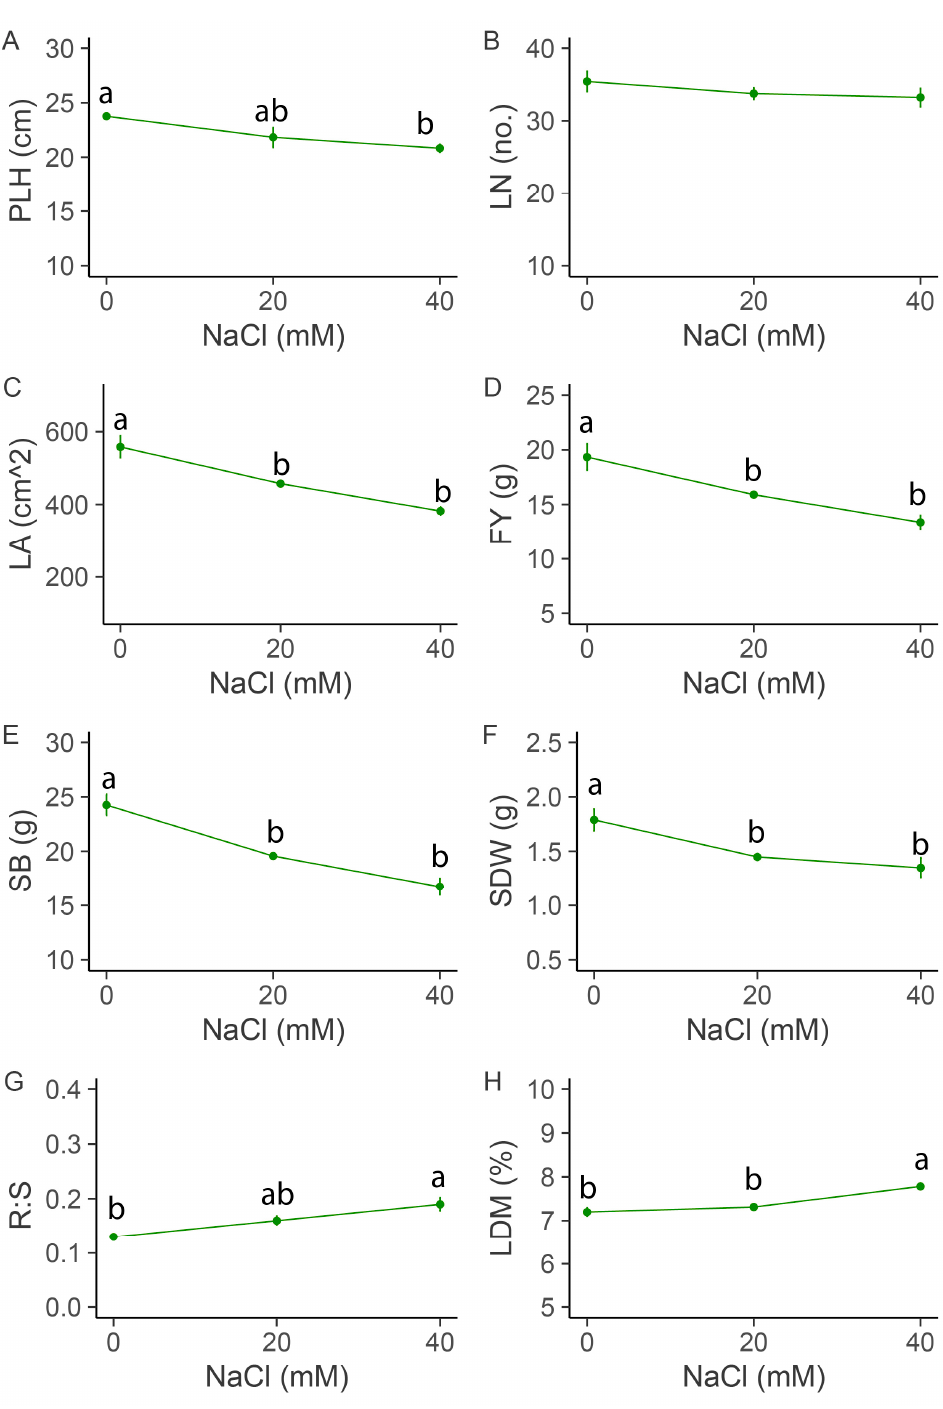
Figure 1. Effects of the NaCl in the nutrient solution on the morphometric traits of basil: ( A ) plant height (PLH); ( B ) leaf number (LN); ( C ) leaf area (LA); ( D ) fresh yield (FY); ( E ) shoot biomass (SB); ( F ) shoot dry weight (SDW); ( G ) root-to-shoot ratio (R:S); ( H ) leaf dry matter (LDM). Data are mean ± standard error of the mean. Different letters indicate significantly different means according to the Tukey HSD test ( p < 0.05).